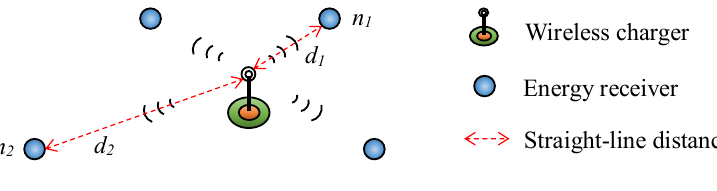
Figure 1. An example of wireless